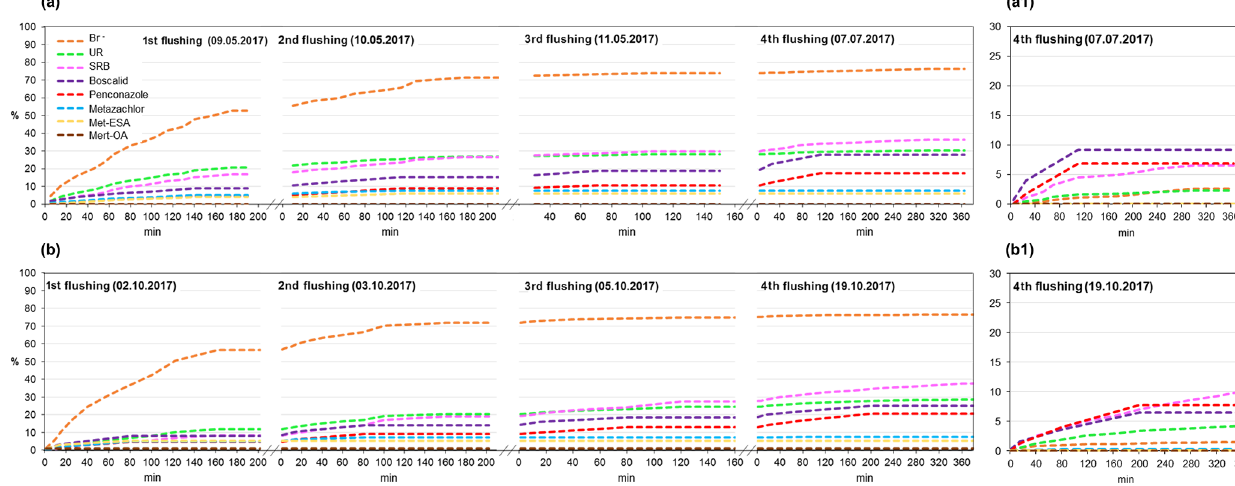
Figure 8. Cumulative recovery curves of tracers, pesticides and their TPs obtained during the flushing phase for the (a) first and (b) second runs. Recovery curves for the fourth flushing are detailed in (a1) and (b1) for the first and second runs, respectively. Table 4. Percentage of tracers, pesticides and their TPs recovered (and the corresponding removals) from the outlet water after the flushing phase for the first and second runs. Recovery water outlet (%) Mean Removal (%) Mean First Second recovery First Second removal run run (%)